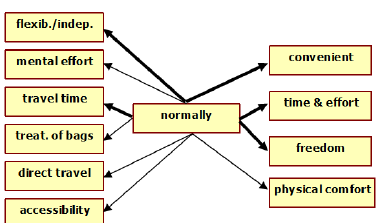
Fig. 11. Central map of one of the clusters (before